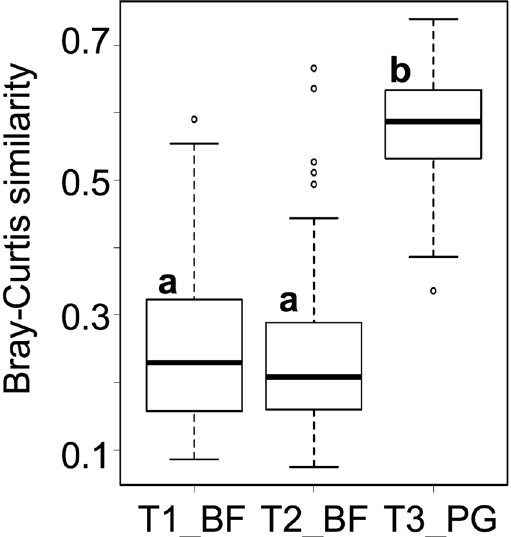
Figure 4. Box plots of Bray-Curtis similarity index between the inoculated and uninoculated communities in the three trials. The bottom, top, and median lines of the boxes represent the first quantiles, third quantiles, and medians, respectively, and the error bars represent the range of the data. The different letters indicate significant differences among the three trials (Steel-Dwass test, p <